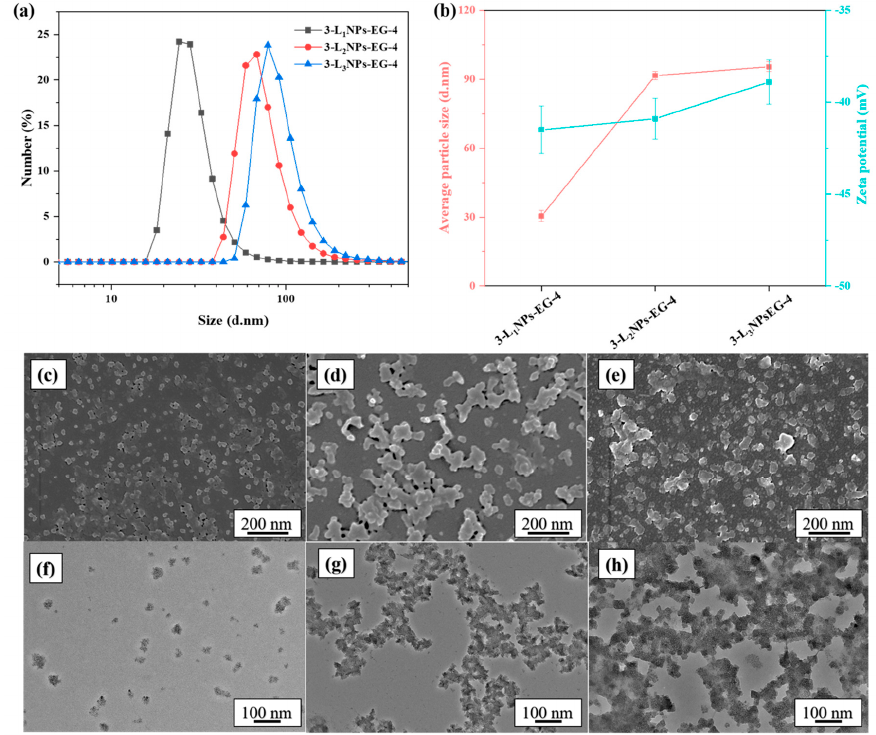
Figure 3. ( a ) Particle size distribution, ( b ) average size and zeta-potential, ( c – e ) SEM and ( f – h ) TEM images of LNPs obtained from different pristine lignin. ( c , f ) 3-L 1 NPs-EG-4, ( d , g ) 3-L 2 NPs-EG-4, ( e , h ) 3-L 3 NPs-EG-4.